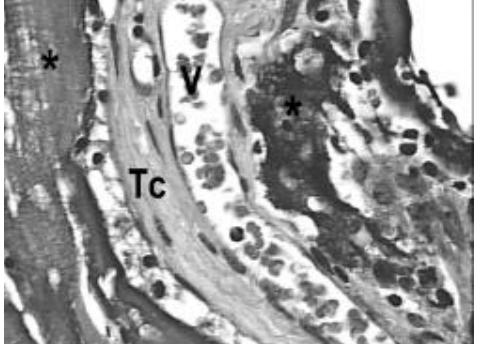
FIGURA 5 - Fotomicrografia do período de 28 dias: Vasos sangüíneos (V), Tecido conjuntivo (Tc) e material implantado entre os feixes musculares (*), HE,